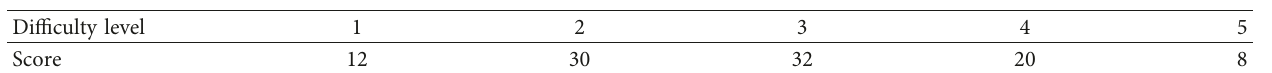
Table 5: Difficulty scores.